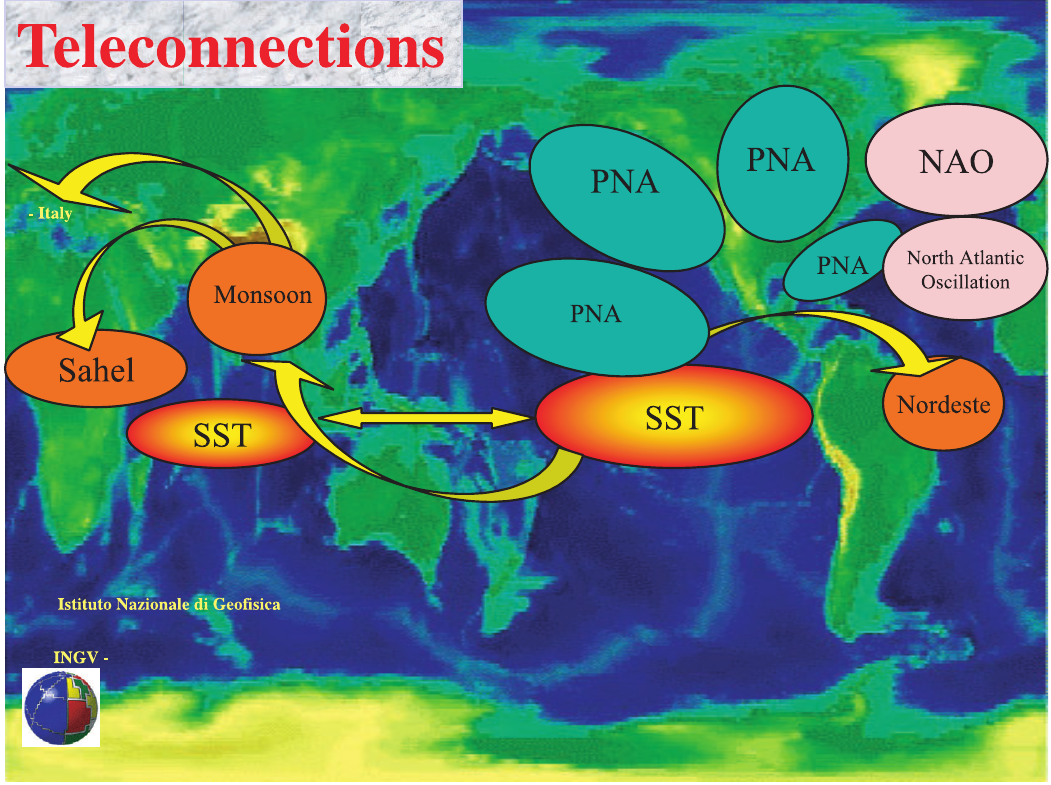
Fig. 1. The interactions between atmosphere and oceans in the tropics dominate the variability at interannual scales. Wavetrains of anomaly stem from the Pacific into the mid-latitudes, as the Pacific North American Pattern (PNA). The tropics are connected through the Pacific SST influence on the Indian Ocean SST and the monsoon, Sahel and Nordeste precipitation. The monsoon area is also connected to the Mediterranean region. Also shown is the North Atlantic Oscillation a major mode of variability in the Euro-Atlantic sector whose coupled nature is still under